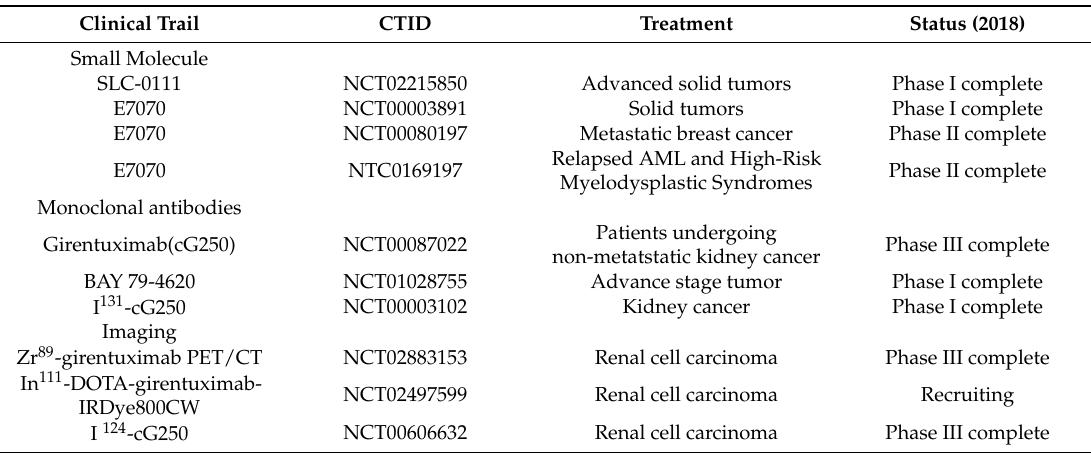
Table 3. List of all ongoing clinical trials for CA IX.